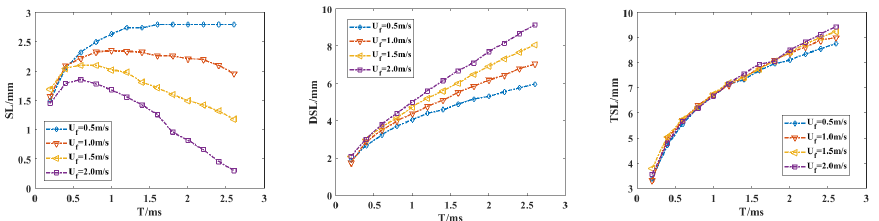
Figure 11. Spreading length at different dynamic film velocities when θ = 30 ◦ .